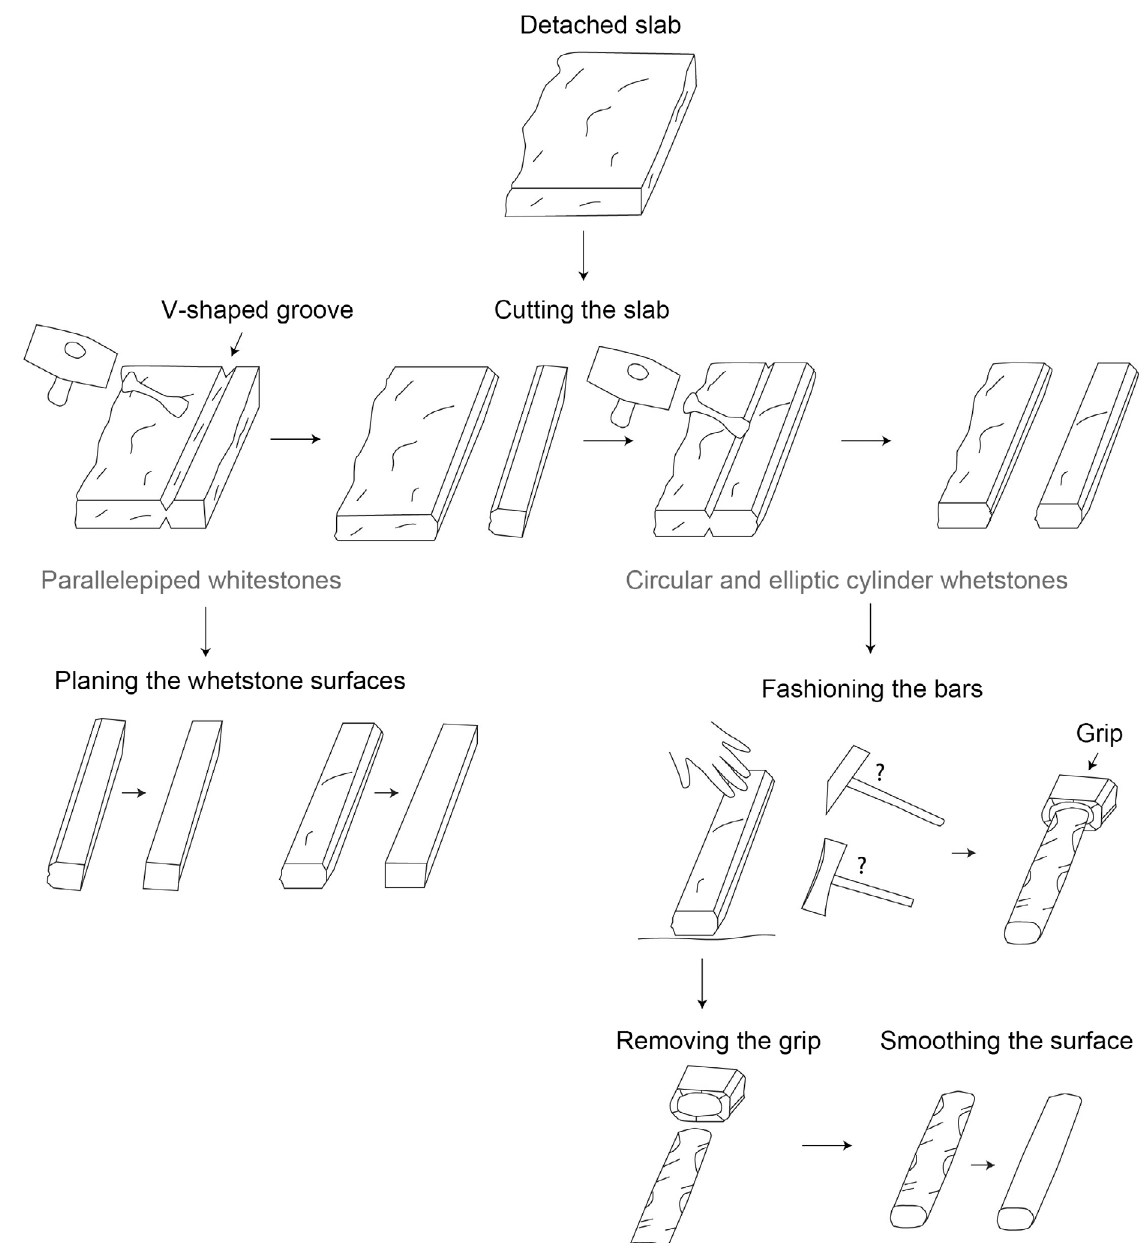
Figure 6: Reconstruction of the whetstone production sequence at the Buizingen and Le Châtelet-sur-Sormonne